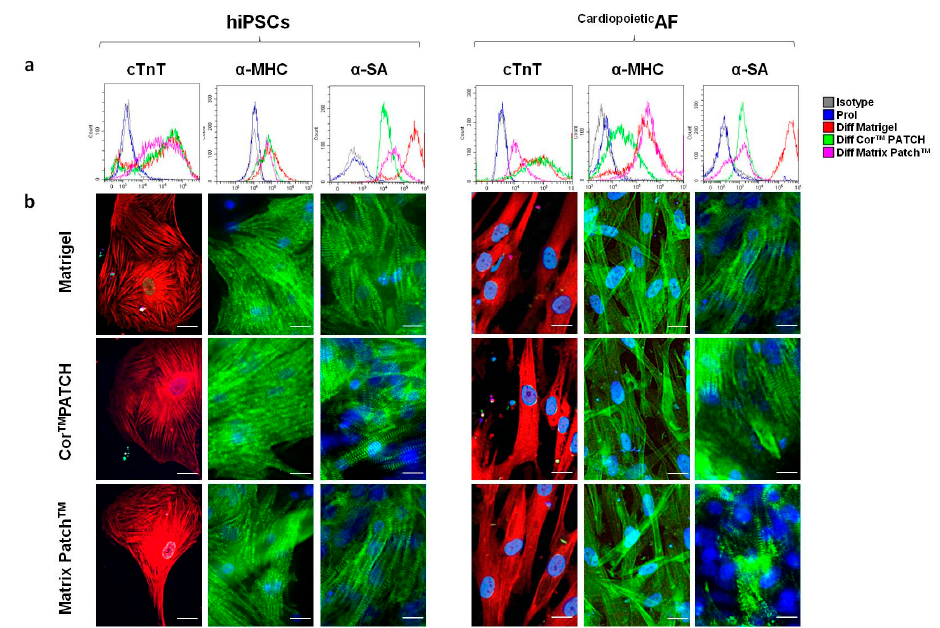
Figure 3. Detection of cTNT, α -MHC, and α -SA in hiPSC- and Cardiopoietic AF-derived cardiomyocytes (CMs), obtained after 15 days of differentiation using Core TM PATCH, Matrix Patch TM , and Matigel, as indicated. ( a ) Flow cytometry analysis of TnT, α -MHC, and α -SA in hIPSCs and Cardiopoietic AF cells, as indicated. Legend of histogram colors: Grey: isotype control; blue: proliferating cells (undifferentiated); red: differentiation on Matrigel ® ; green: differentiation on Cor TM Patch; purple: differentiation on Matrix Patch TM . ( b ) Immunofluorescent staining for cTnT (red), α -MHC (green), and α -SA (green) in hIPSCs and Cardiopoietic AF cells on Core TM PATCH, Matrix Patch TM , or Matrigel ® , as indicated. The nuclei were counterstained with DAPI (blue). Scale bar: 10 μ m. Data are representative of five independent experiments. Table 1. Percentage of cells positive for cTnT, α -MHC, α -SA, CACNA1C, and SERCA2 in hiPSC- and Cardiopoietic AF-derived CMs after 15 days of di ff